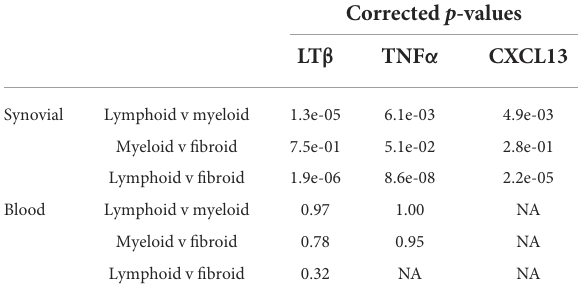
TABLE 4 Correlation of synovial tissue CXCL13 with blood TNF- α and LT- β in RA synovial pathotypes. All pathotypes Lymphoid pathotype only Blood TNF α